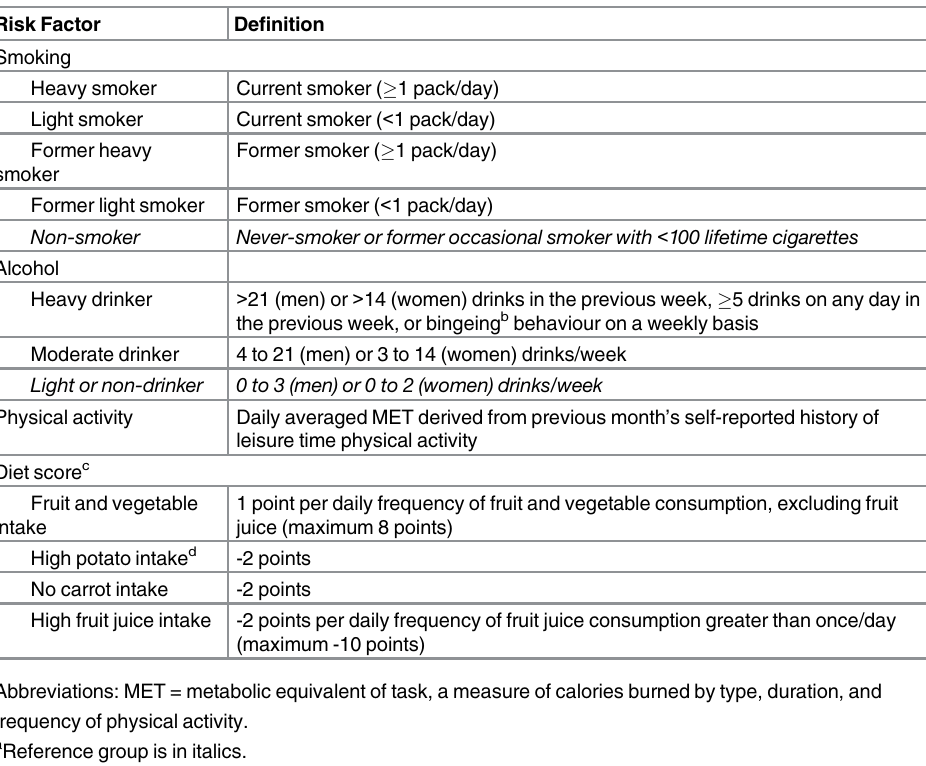
Table 1. Definitions of risk factors.